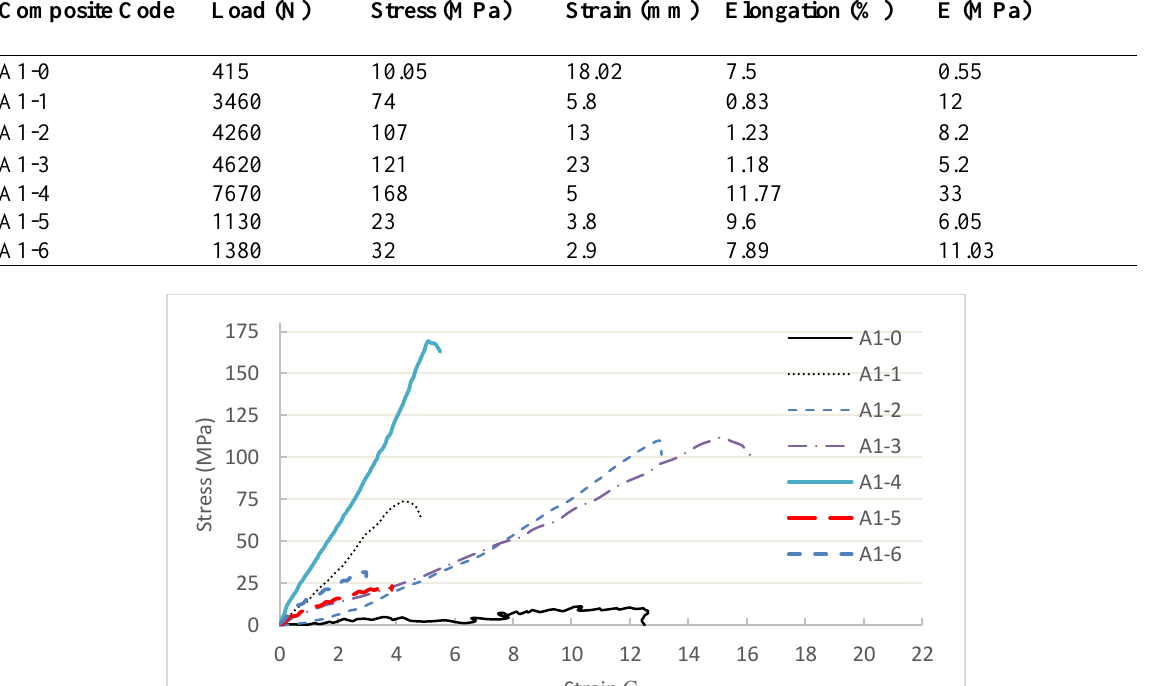
Tensile test results